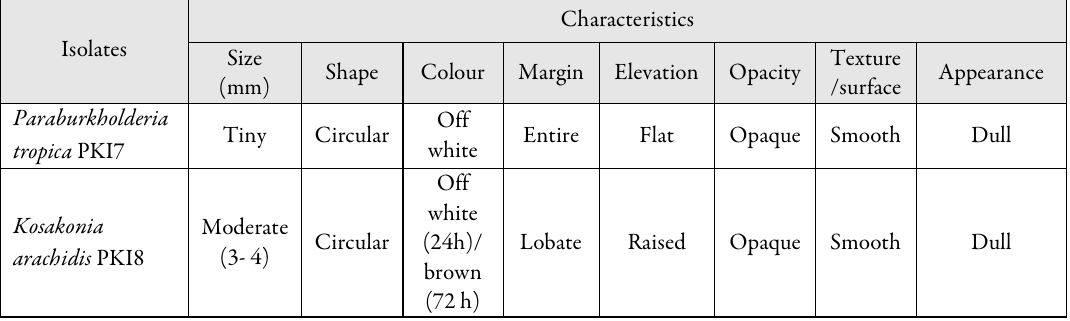
Table 1. Colony characteristics of the bacterial